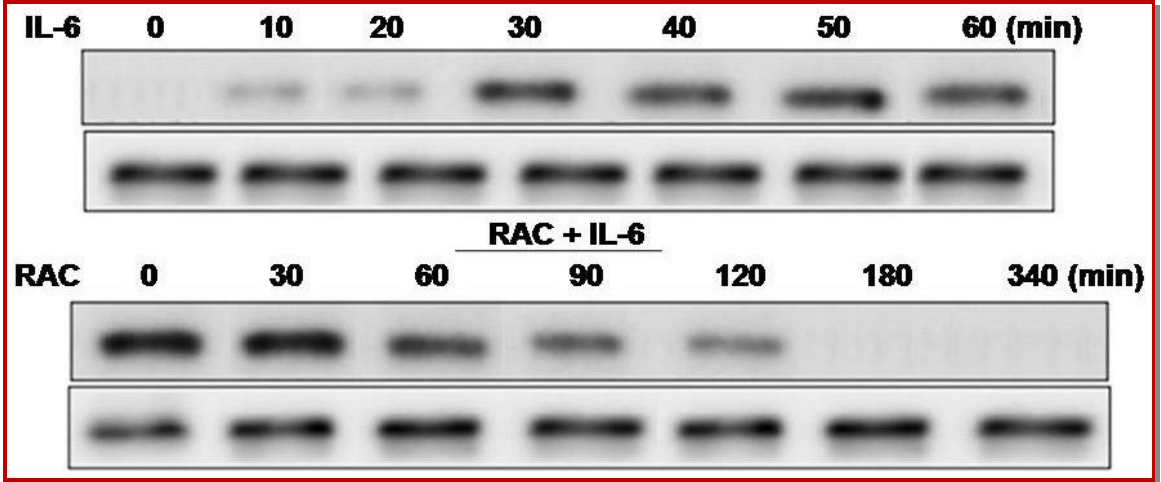
Figure 4: 2-Florobenzaldehyde retinoic acid conjugate inhibited IL-6-induced phospho-STAT3. IL-6 enhanced the expression of JAK2 protein. RAC inhibited IL-6 induced expression of JAK2